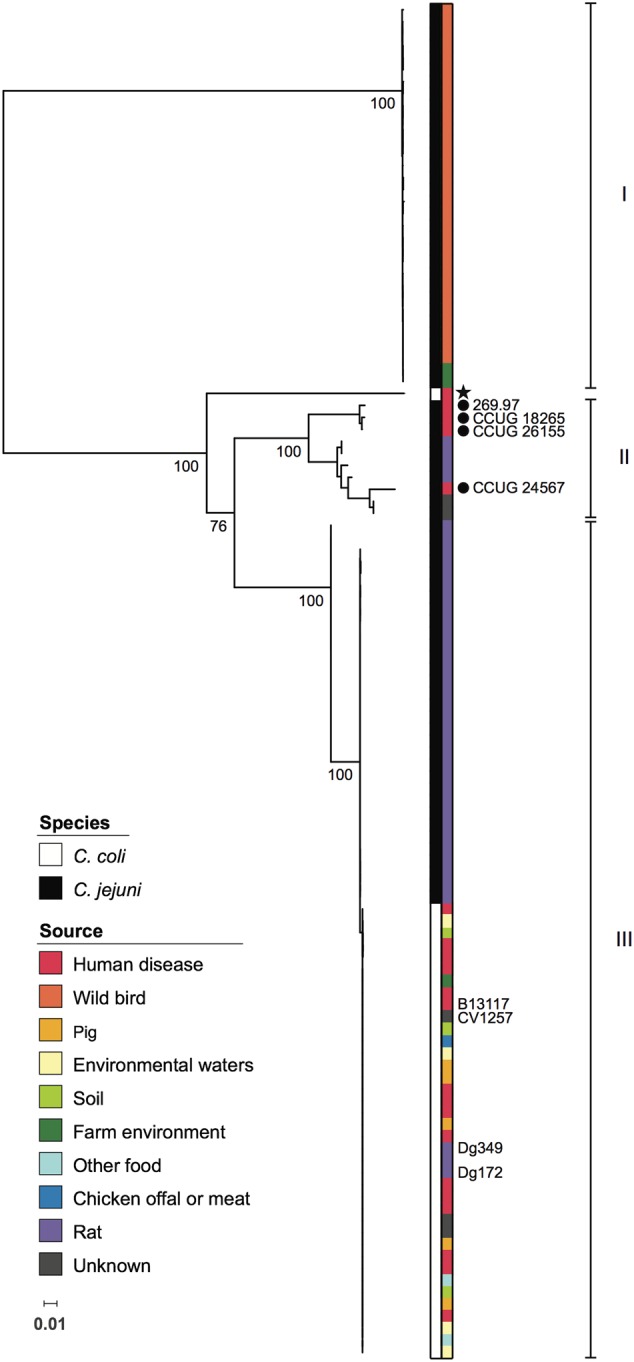
Phylogenetic relationships among Campylobacter glc loci. Maximum likelihood tree based on concatenated nucleotide sequences of genes comprising the glc locus, encoding the Entner-Doudoroff pathway, from 113 Campylobacter isolates. Colored strips adjacent to the phylogeny indicate species and source as shown in the inset legends. Known C. jejuni subsp. doylei isolates are indicated with filled circles. All C. coli isolates were assigned to C. coli clade 1, with the exception of a single clade 3 isolate, which is marked with a star. Isolates included in experiments carried out in this study are labeled. Roman numerals indicate groups of glc sequences referred to in the text. For major nodes, bootstrap values generated from 500 replicates are shown as percentages. The scale bar represents the number of nucleotide substitutions per site.